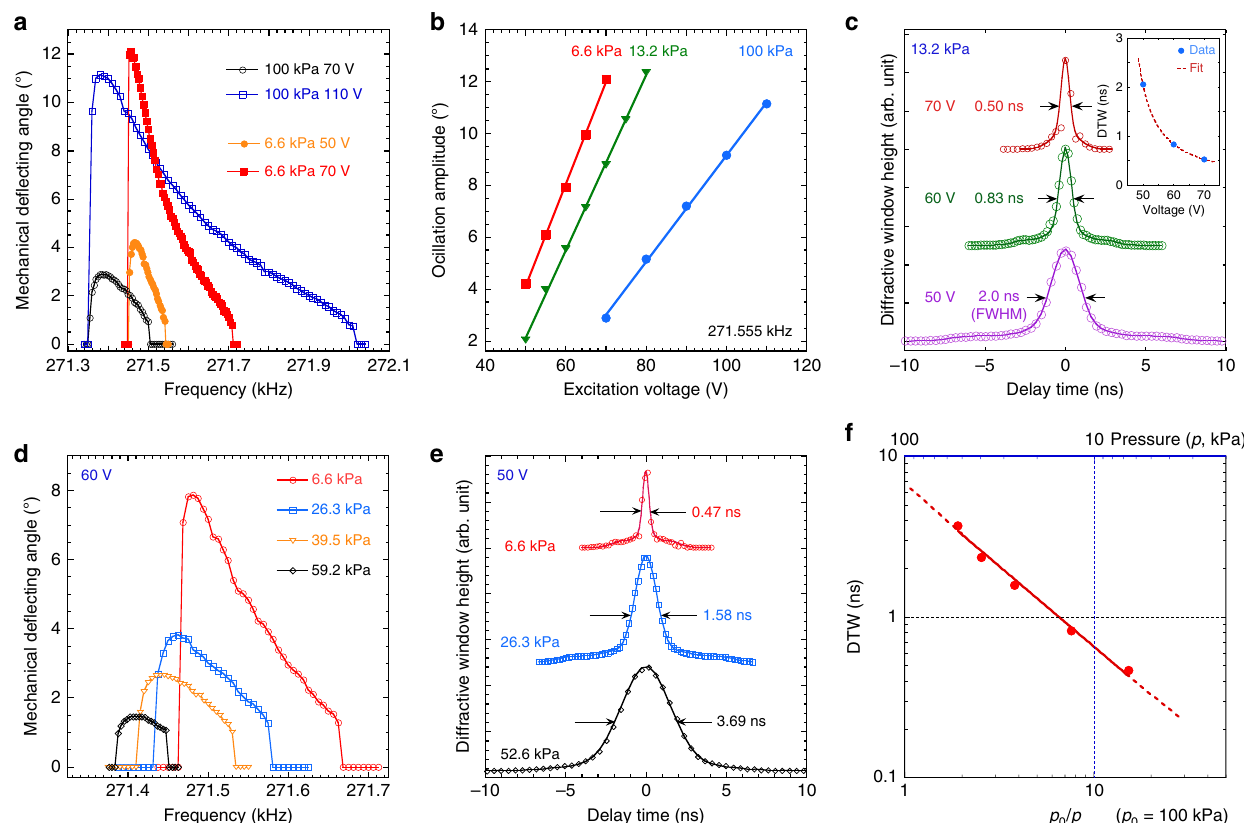
Fig. 4 Performance of higher-frequency (P0) MEMS resonators operated in vacuum. a Tuning curves of the P0 device at atmospheric pressure (100kPa) environment at the onset voltage of 70V (black) and at a very high voltage of 110V (blue), and in a reduced pressure of 6.6kPa at 50V (orange) and 70V (red). At 6.6kPa, similar oscillation amplitudes can be achieved at much lower voltages and the Q factor of the oscillation is also improved as the tuning curves become much narrower. b Dependence of the oscillation amplitude on excitation voltage at 100kPa and reduced pressures. Note that an amplitude of 10° can be achieved at lower voltages of 70V (13.2kPa) and 60V (6.6kPa). c DTW measurement using delay time scans at excitation voltage ranging from 50 to 70V at a reduced pressure of 13.2kPa. The DTW width reaches 0.5ns at a moderate voltage of 70V. The dependence of the DTW on the excitation voltage is shown in the inset to the fi gure, where the fi t (line) assumes a linear relationship between the oscillation amplitude and the voltage. d Tuning curves of the P0 device operated in a pressure range from 59.2kPa down to 6.6kPa at an excitation voltage 60V. e Time delay scans of the high-frequency device at 52.6, 26.3, and 6.6kPa at 60V. The DTW width reaches below 0.5ns at 6.6kPa even at this modest excitation voltage. f Dependence of DTW on the environmental pressure at 60V. The DTW width (circle) decreases almost one order of magnitude from 3.69ns to 0.47ns as the pressure drops from 52.6 to